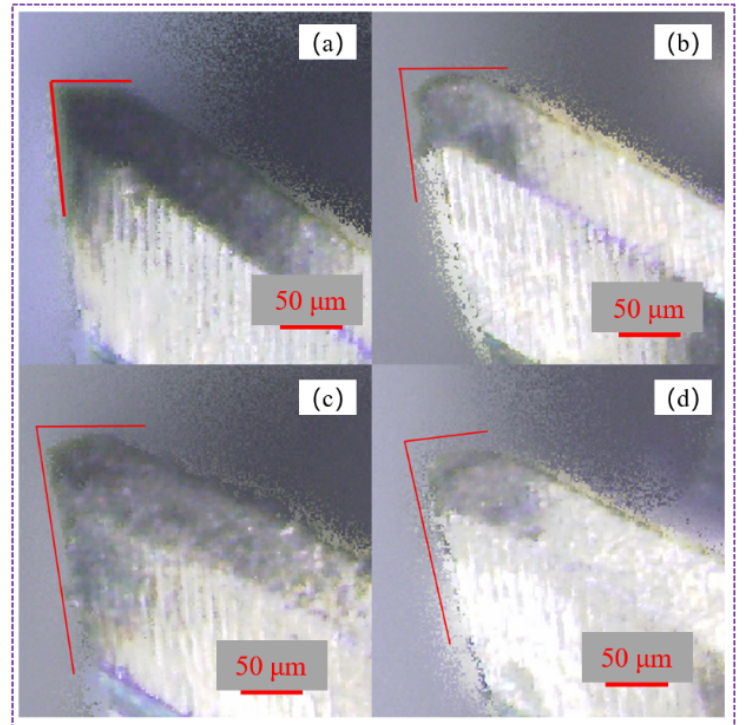
Figure 10. Wear analysis of micro milling cutters with different wear states. ( a ) Initial’s flank wear profile, ( b ) Wear I’s flank wear profile, ( c ) Wear II’s flank wear profile and ( d ) Wear III’s flank wear profile.